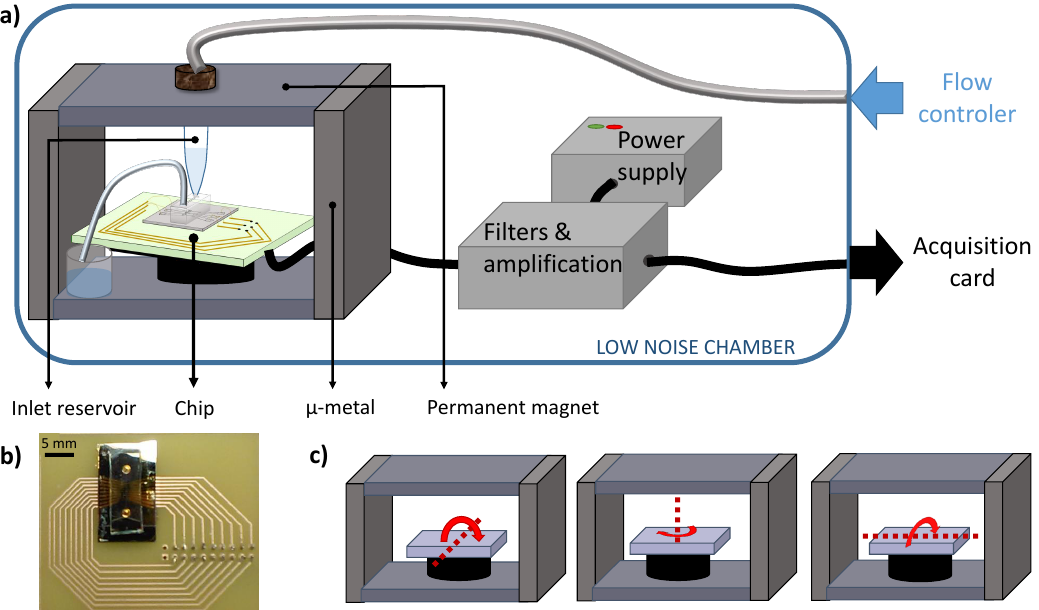
Figure 1. Experimental set-up and data. ( a ) The chip, the reservoir and the collecting vial are inserted in a homogeneous magnetic field. A computer program is controlling the flow using a pressure driver. The applied pressure is set to 300 mbar. Homemade electronic boxes deliver power to the sensor, amplify and filter the signals before sending the data outside the low-noise chamber to the acquisition card. ( b ) Chip photograph. ( c ) Positioning